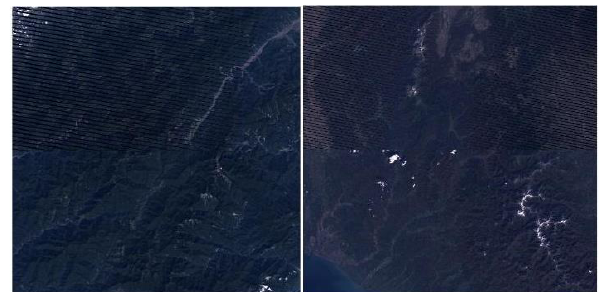
Figure 3. Mosaic images of Landsat 7 (up) and Landsat 8 (down) of normalized images. Taiwan (left), Japan (right).